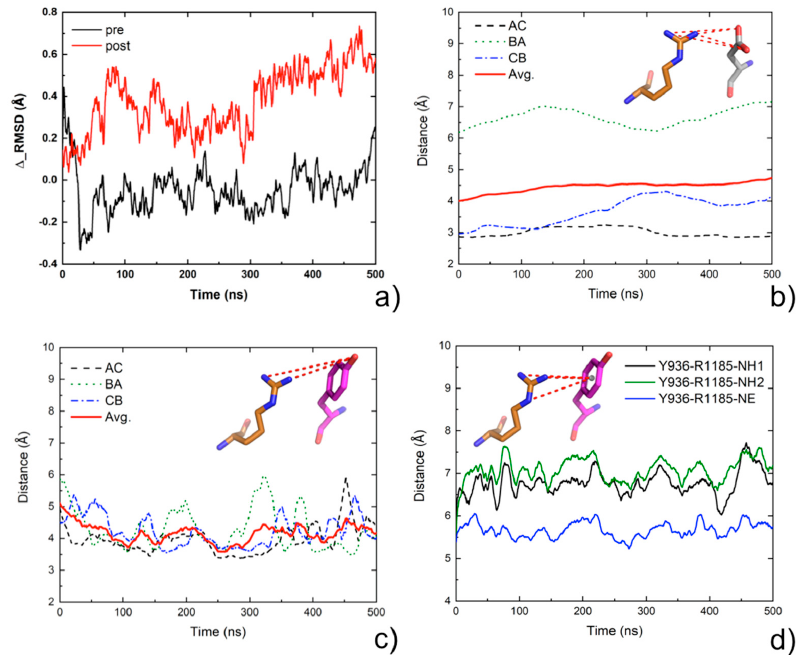
Figure 5. Comparative MD analysis of the Wuhan reference S protein and the D936Y mutant. ( a ) rmsd difference (rmsd) between the wild-type and the mutant in the pre-fusion (black) and post-fusion (red) conformation, averaged over the three independent 500-ns simulations per system. ( b ) Wild-type: minimum distance over time between the carboxylate oxygens of D936 and the guanidinium nitrogens of R1185 on the adjacent monomer, averaged over the three independent simulations per system. Values per single trimer interfaces are plotted as dashed lines while the average values over the three interfaces are plotted as a continuous red line. ( c ) Mutant: minimum distance over time between the hydroxyl oxygen of Y936 and the guanidinium nitrogen of R1185 on the adjacent monomer, averaged over the three independent simulations per system. Values per single trimer interfaces are plotted as dashed lines while the average values over the three interfaces are plotted as a continuous red line. ( d ) Mutant: distances over time between the center of mass of the Y936 aromatic ring and the guanidinium nitrogen of R1185 on the adjacent monomer, averaged over the three independent simulations and the three